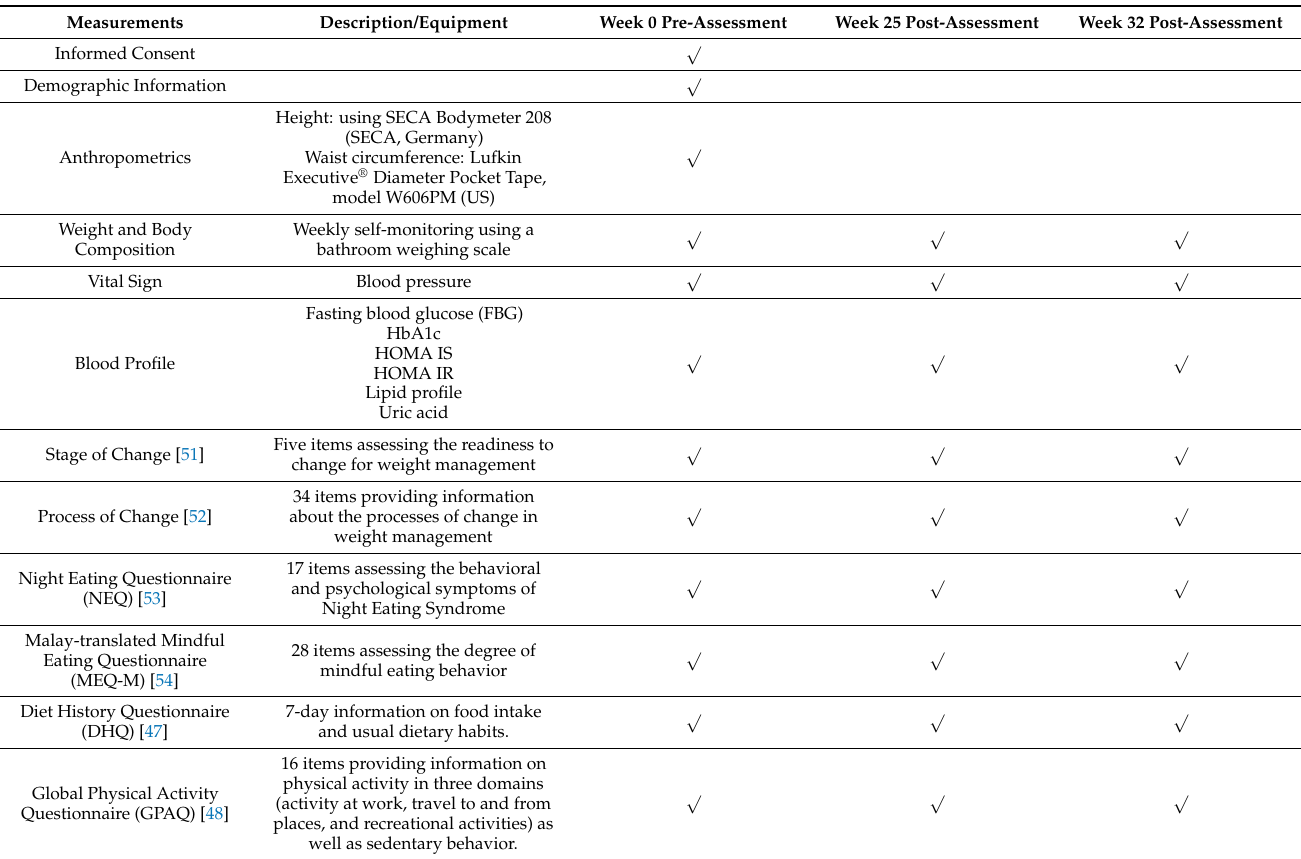
Table 3. Pre- and post-intervention